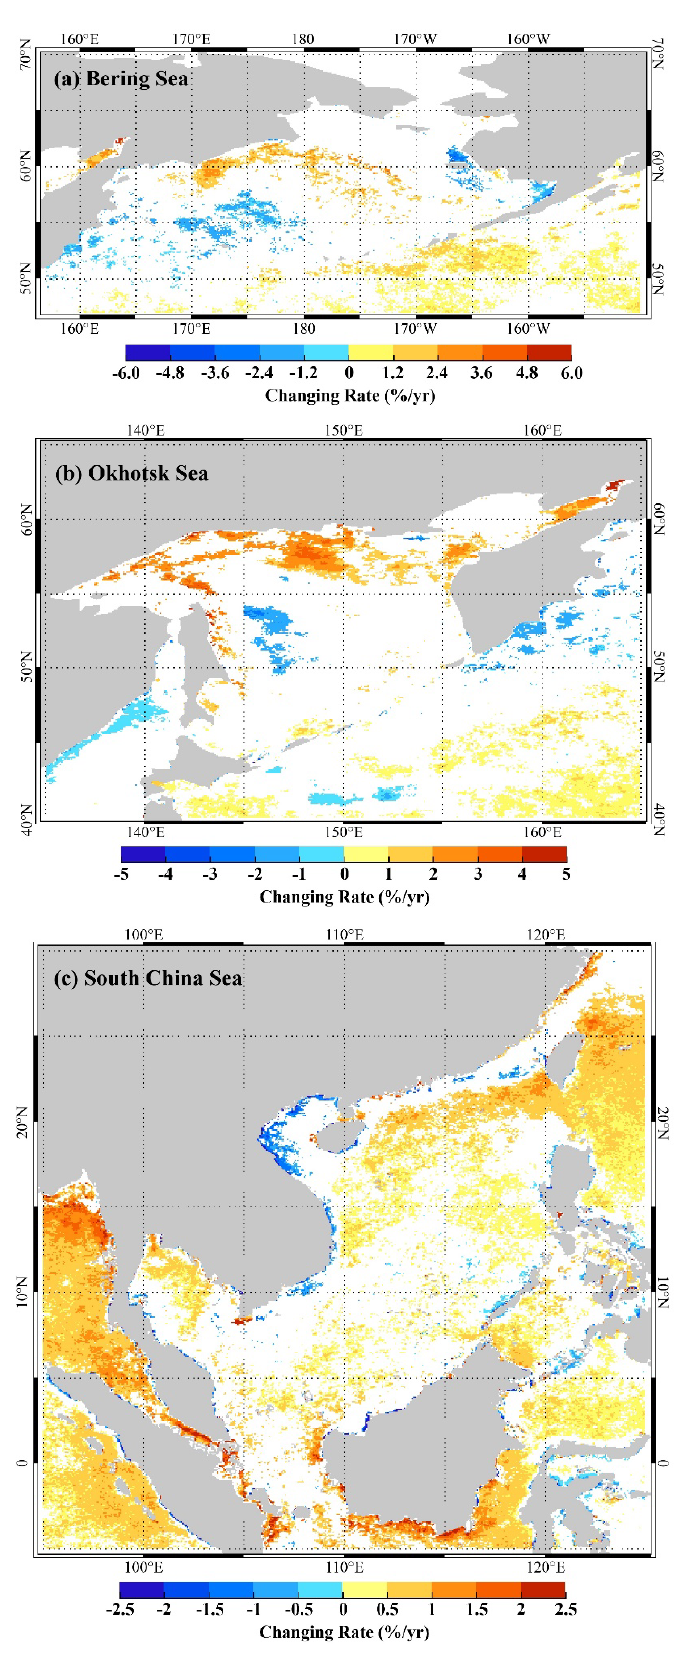
Figure 7. Trend maps of SDD in the ( a ) Bering, ( b ) Okhotsk, and ( c ) South China Seas during 1998–2018 (Bright colors show pixels with p < 0.1).